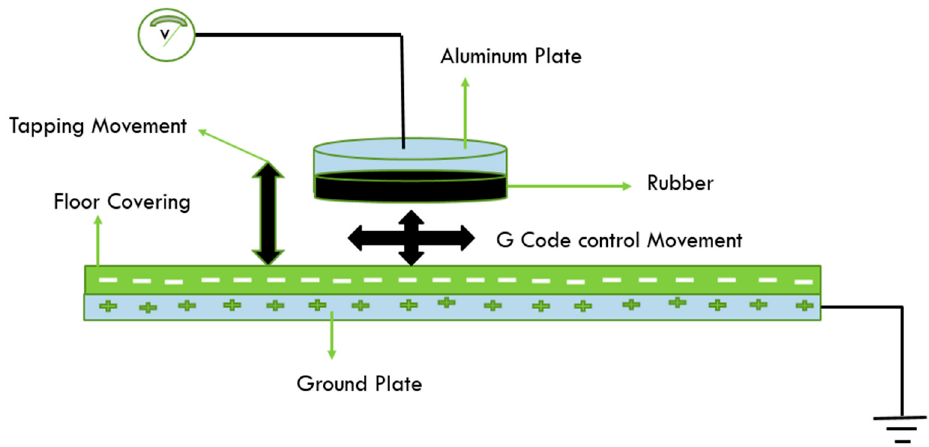
Figure 10. Schematic diagram of the new device with automated foot controlled by G-code, allowing for a specific and controlled movement on the floorcoverings for characterize the electrostatic behavior.